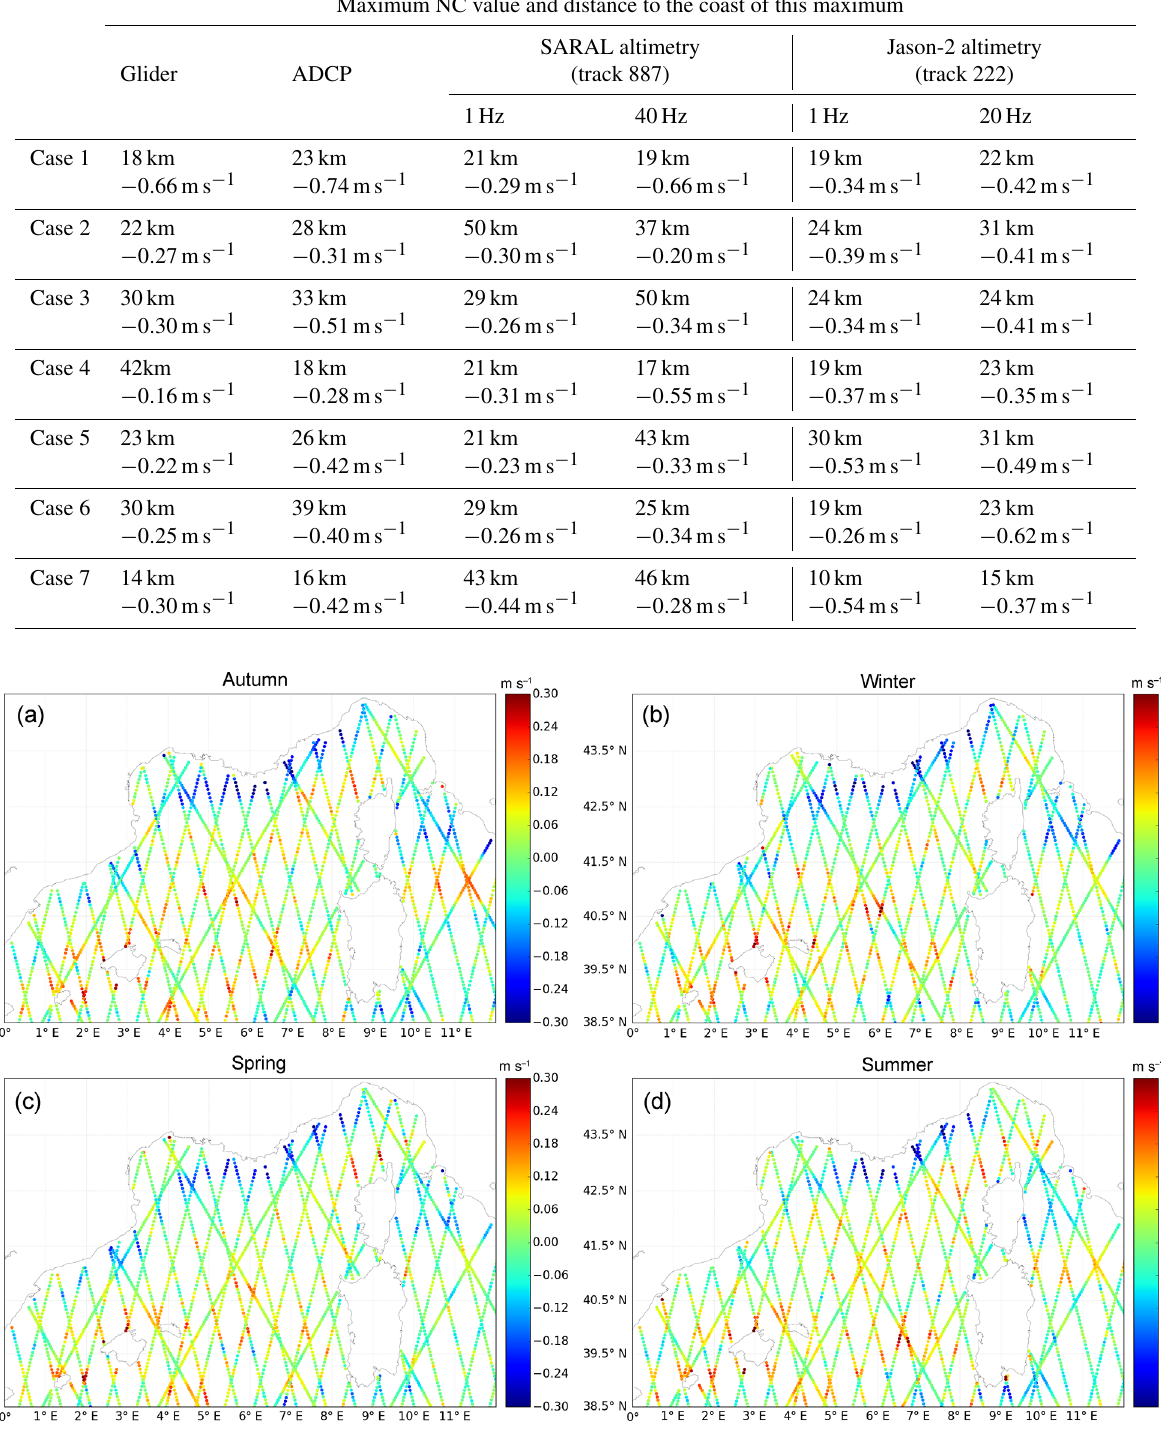
Figure 8. Seasonal climatology maps of cross-track geostrophic currents (in ms − 1 ) derived from Jason-2 and SARAL/AltiKa altimeter data over the period April 2013–April